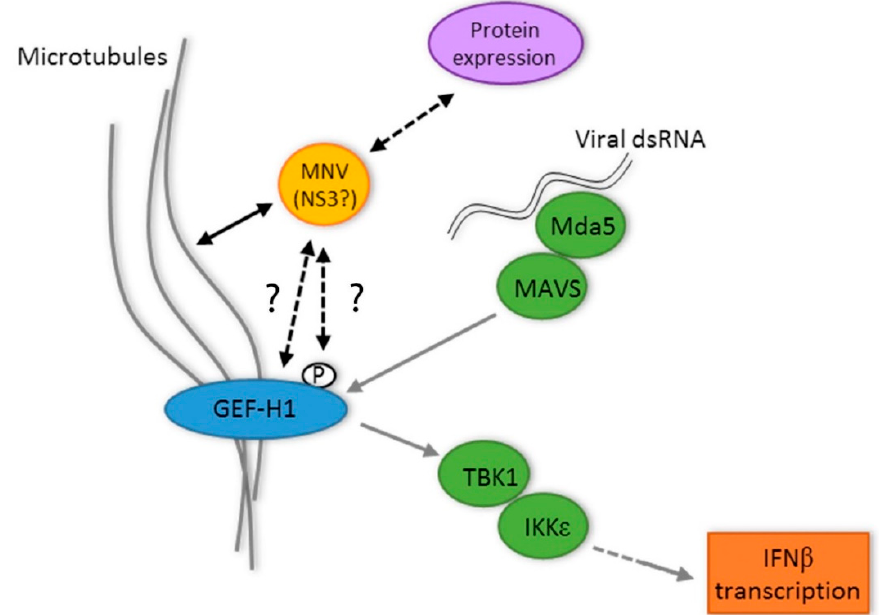
Figure 7. Proposed for the interplay between GEF-H1, MNV replication, microtubules, the MNV NS3 protein, and the innate immune response during the MNV infection of macrophages. Question marks (?) indicate unanswered understanding between the MNV NS3 protein and GEF-H1.